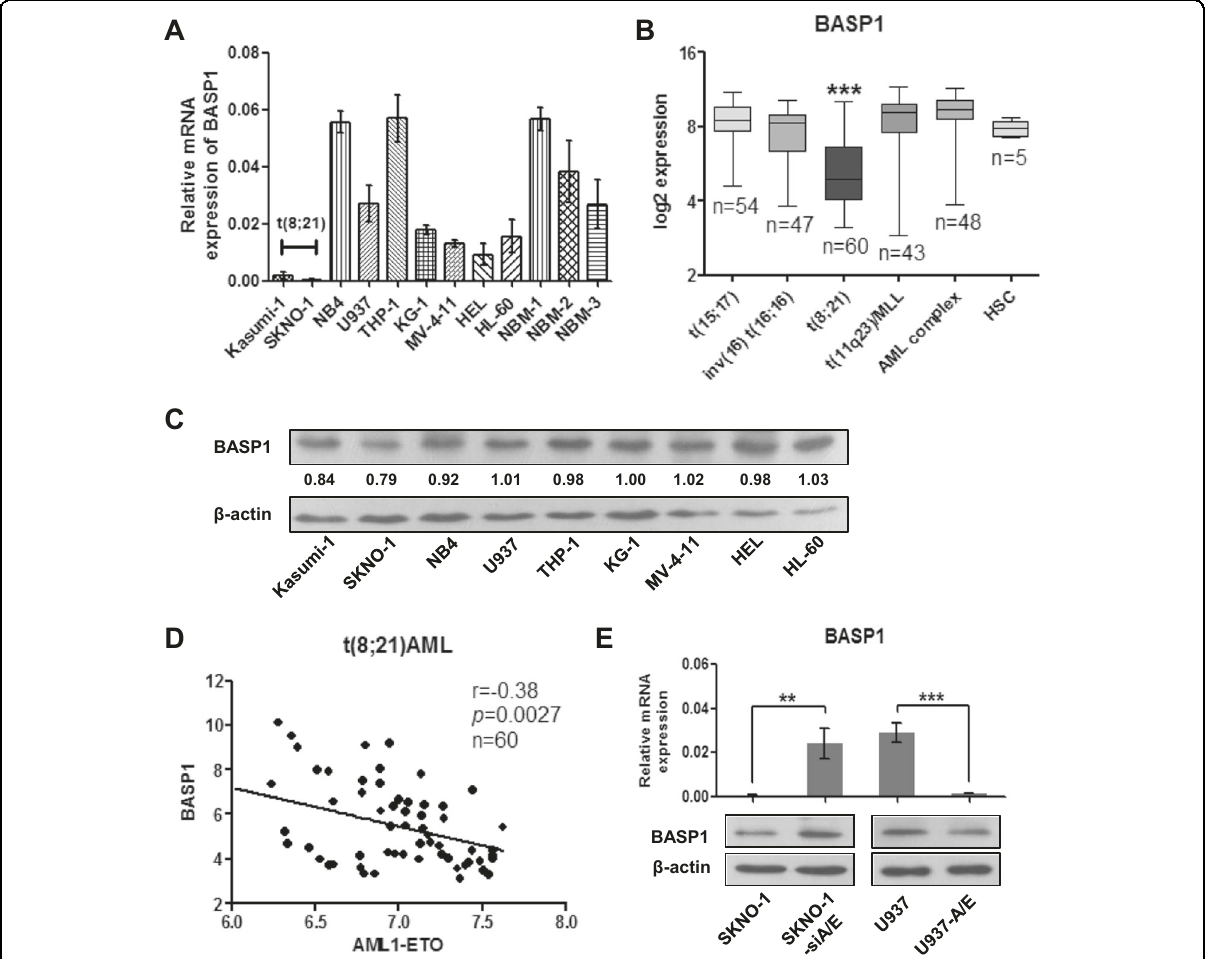
Fig. 1 BASP1 expression is selectively down-regulated in A/E-positive AML. a Expression of BASP1 is down-regulated in A/E-positive cell lines (Kasumi-1 and SKNO-1) compared to the other A/E-negative AML cell lines (NB4, U937, THP-1, KG-1, MV-4-11, HEL, and HL-60) and three sets of normal bone marrow (NBM). b Expression of BASP1 in different subtypes of AML and hematopoietic stem cells (HSC) analyzed from the GEO dataset (GSE13159). BASP1 expression was down-regulated in t(8;21) AML in contrast to the other subtypes of AML and HSC (*** p < 0.001). c The protein level of BASP1 was detected by western blotting in AML cell lines. β -actin was used as a control. d mRNA expression of BASP1 was plotted against that of AML1-ETO in A/E-positive AML ( n = 60) (GSE13159). The plot of BASP1 versus AML1-ETO expression showed an inverse correlation ( r = -0.38, p = 0.0027). e Upper panel: mRNA expression of BASP1 was measured in two pairs of cell lines: SKNO-1 and SKNO-1-siA/E, and U937 and U937-A/E. GAPDH was used as a control (** p < 0.01, *** p < 0.001). Lower panel: The protein levels of BASP1 were detected by western blotting. β -Actin was